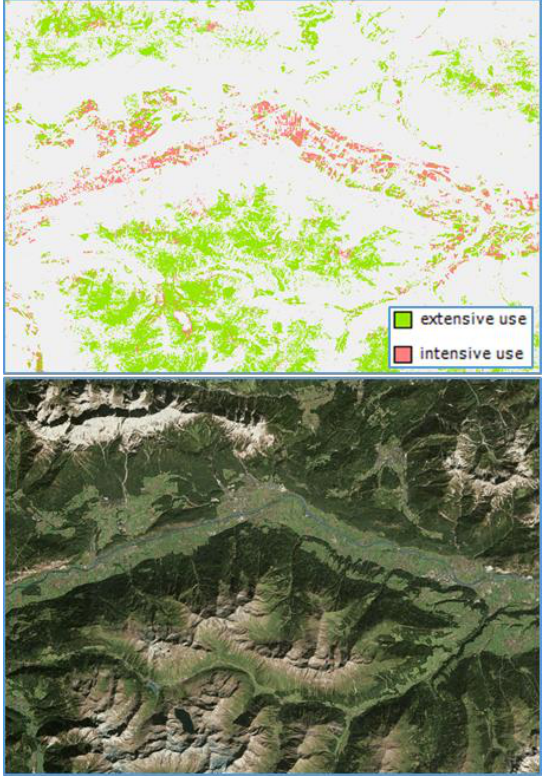
Figure 3. Grassland intensity layer 2018 (upper figure) compared to Bing Maps Aerial of the same region The current temporal density of optical time-series from Sentinel-2 for the years 2017 and 2016 restricted the applicability of time series methods, as reflectance trajectories depend on the grassland dynamics over the vegetation period such as e.g. mowing events. The high cloud coverage in 2018 in central Europe limits the method of comparing NDVIs of consecutive acquisition dates: mowing events may not be detected in areas covered by clouds for long periods. Filtering improved look and feel by reducing noise. For the use intensity layer, a filter of 4 pixels in size was applied. All areas within the grassland mask where filtered, so that there are no intensity classes smaller than 5 pixels in the end. Within small